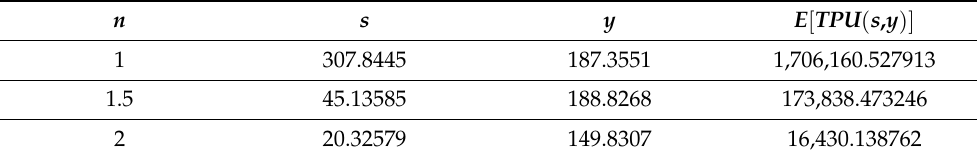
Table 2. Optimal Solution for Example 2 for n = {1,1.5,2}.